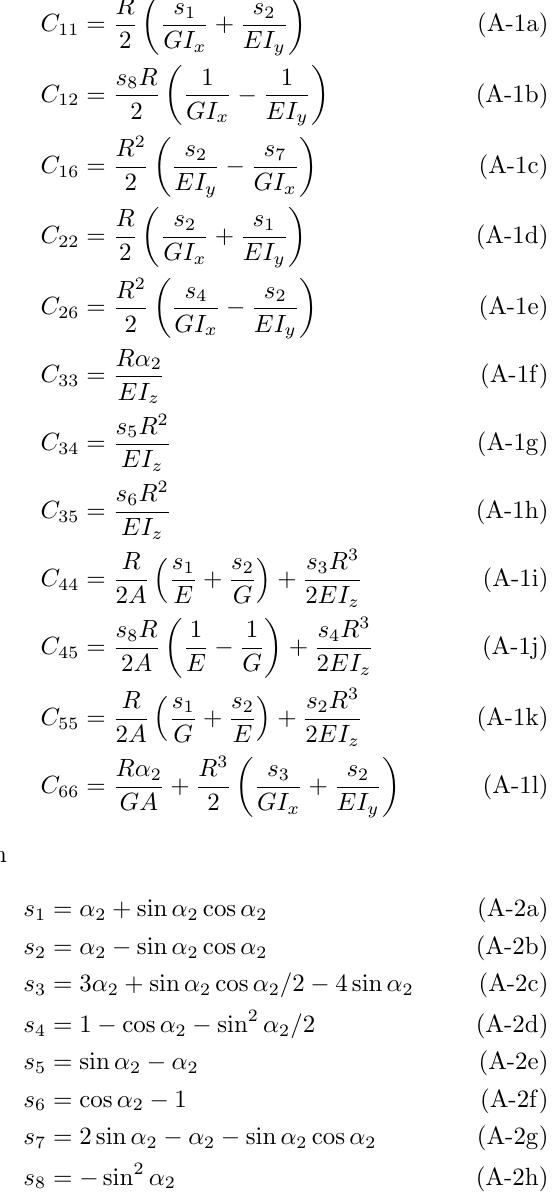
where E is the Young’s modulus and G = E/ 2(1 + ν ) is the shear modulus with the Poisson’s ratio ν . I x , I y and I z are the moments of inertia, respectively. A is the area of the